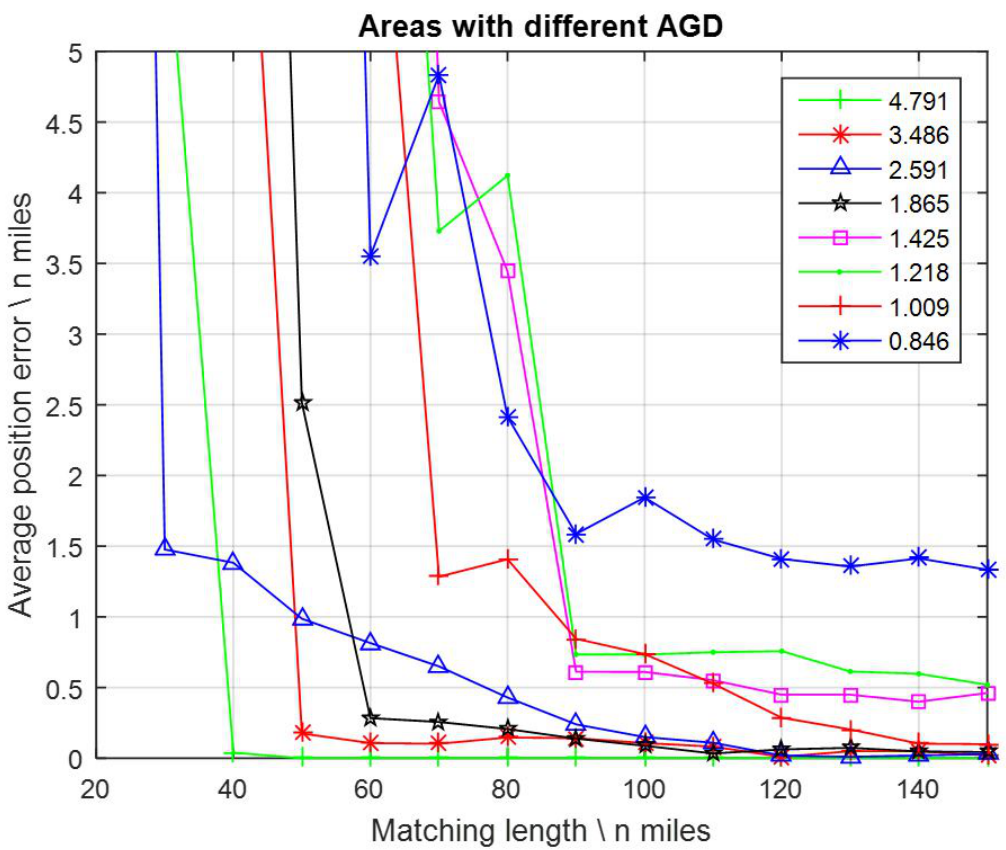
Figure 9. Average position errors in different